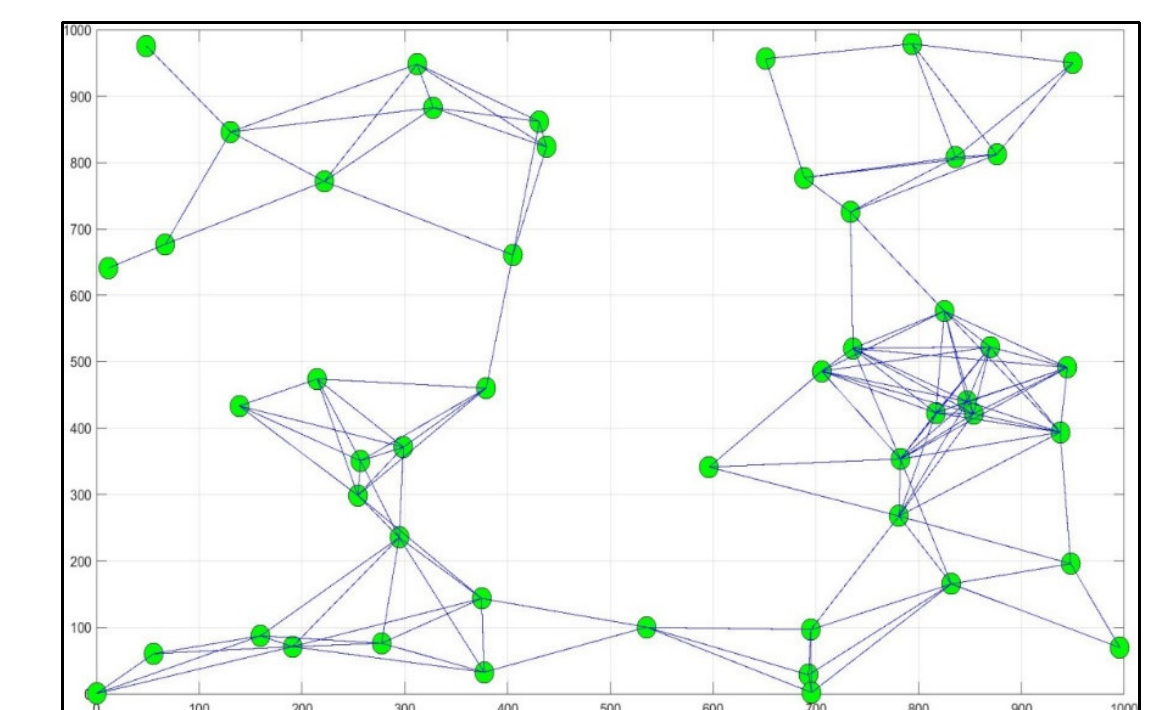
Figure 17. Possible routes between all locations.